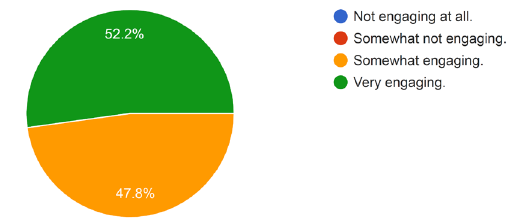
Fig. 7 – Contribution from the on-line quizzes to learning.